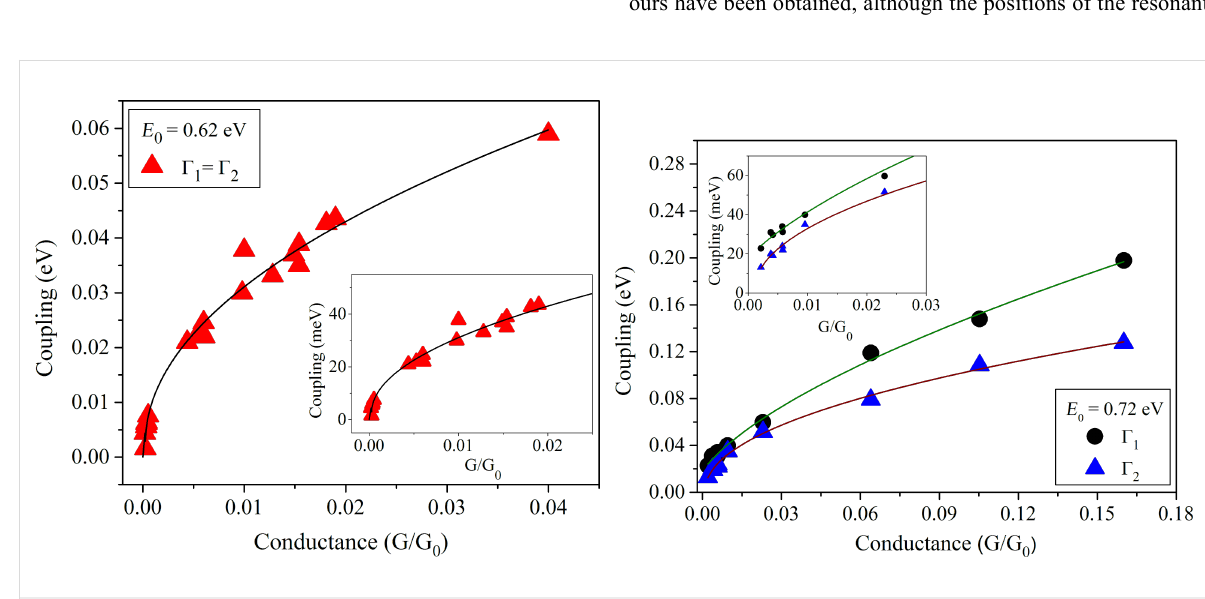
Figure 7: Coupling parameters as a function of 0 V-conductance extracted from the single level model fit for the symmetric M1 molecule (left panel), and for the asymmetric M2 (right panel). The lines drawn correspond to a square root dependence of the coupling parameters on conductance.